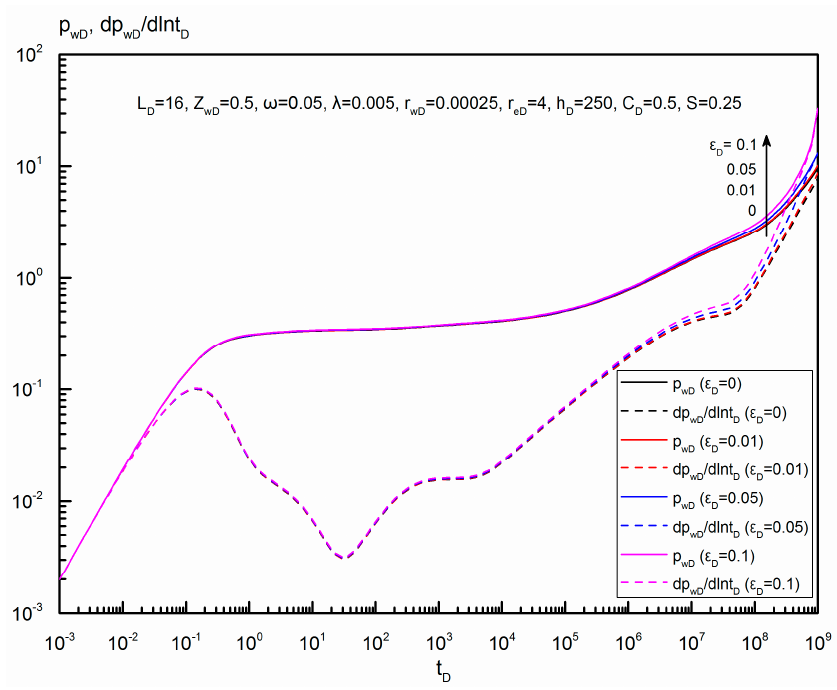
ε ) on horizontal well’s transient pressure